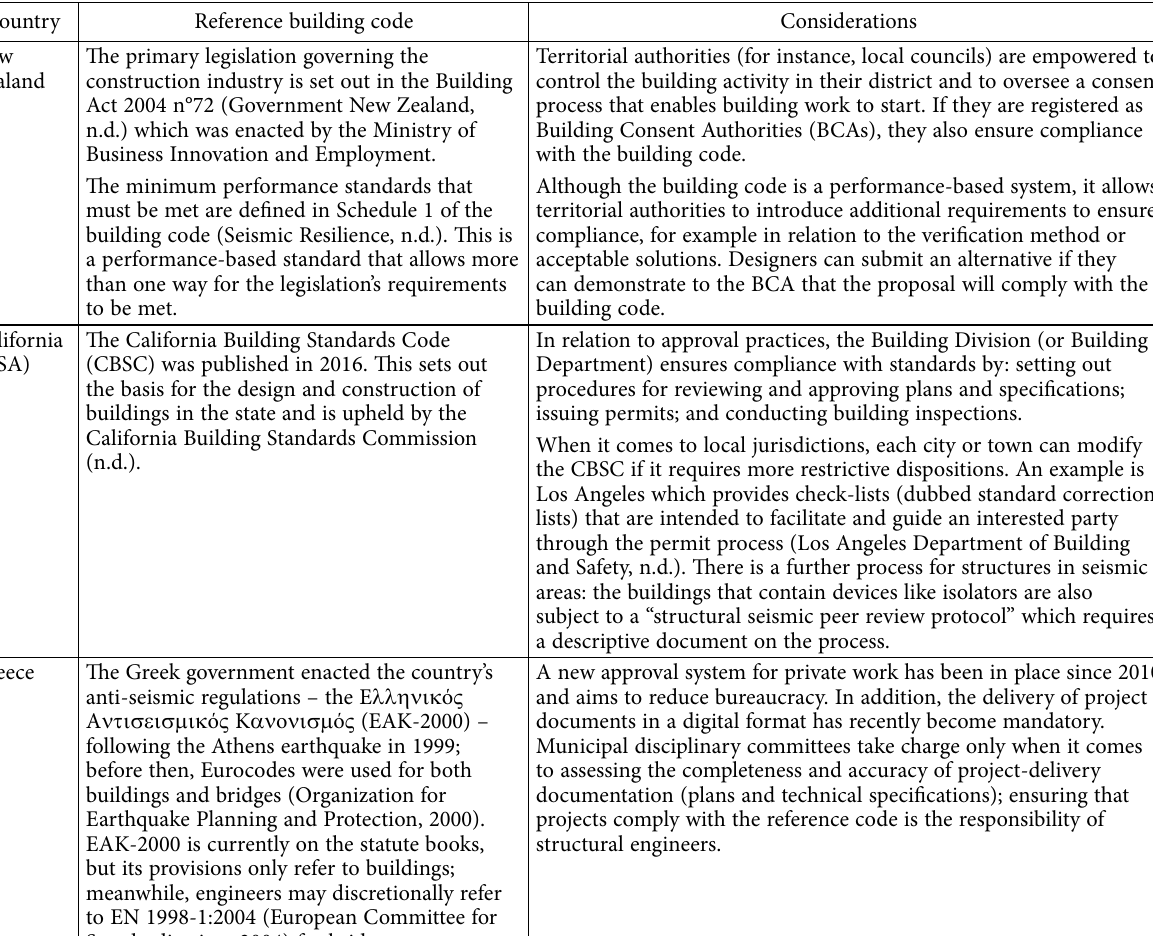
Table 3. Summary of reference building codes and enforcement strategies in New Zealand, California and Greece Country